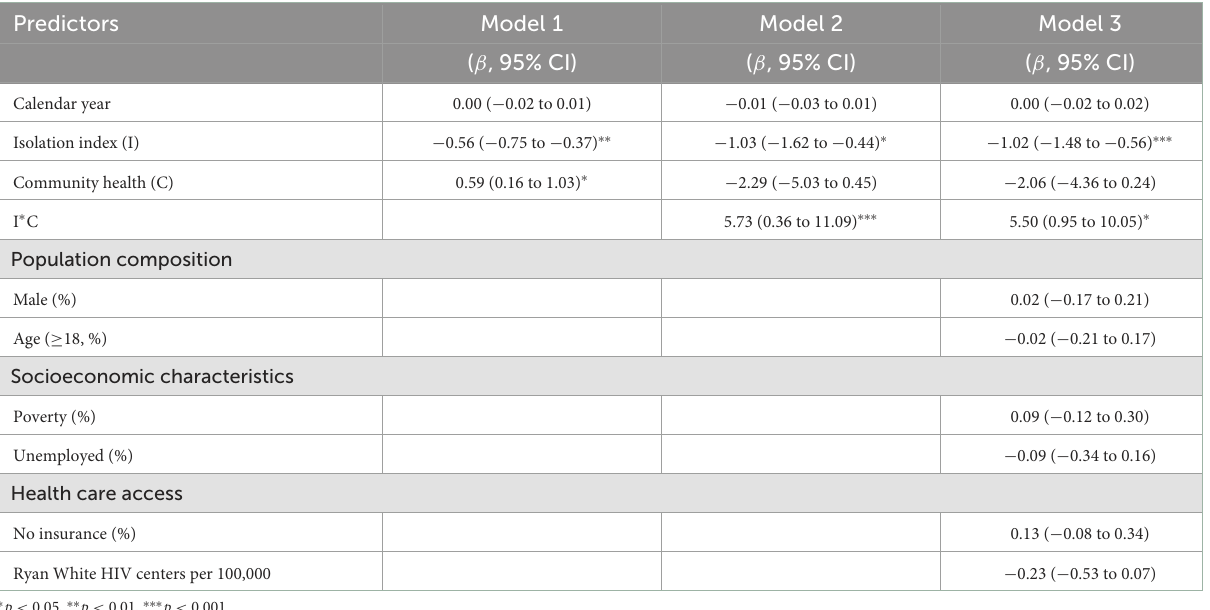
TABLE 3 Regression coefficients for viral suppression rate among people living with HIV across 46 counties in South Carolina from 2013 to 2018.